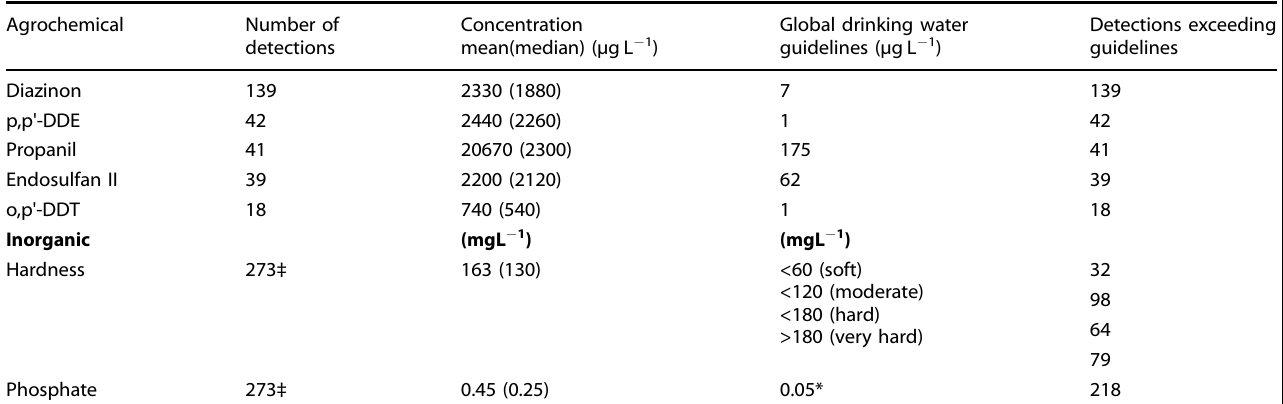
Table 2. Agrochemicals detected in domestic well in Wilgamuwa, Sri Lanka during 2018 water sampling from Shipley et al. (2022) 24 . Agrochemical